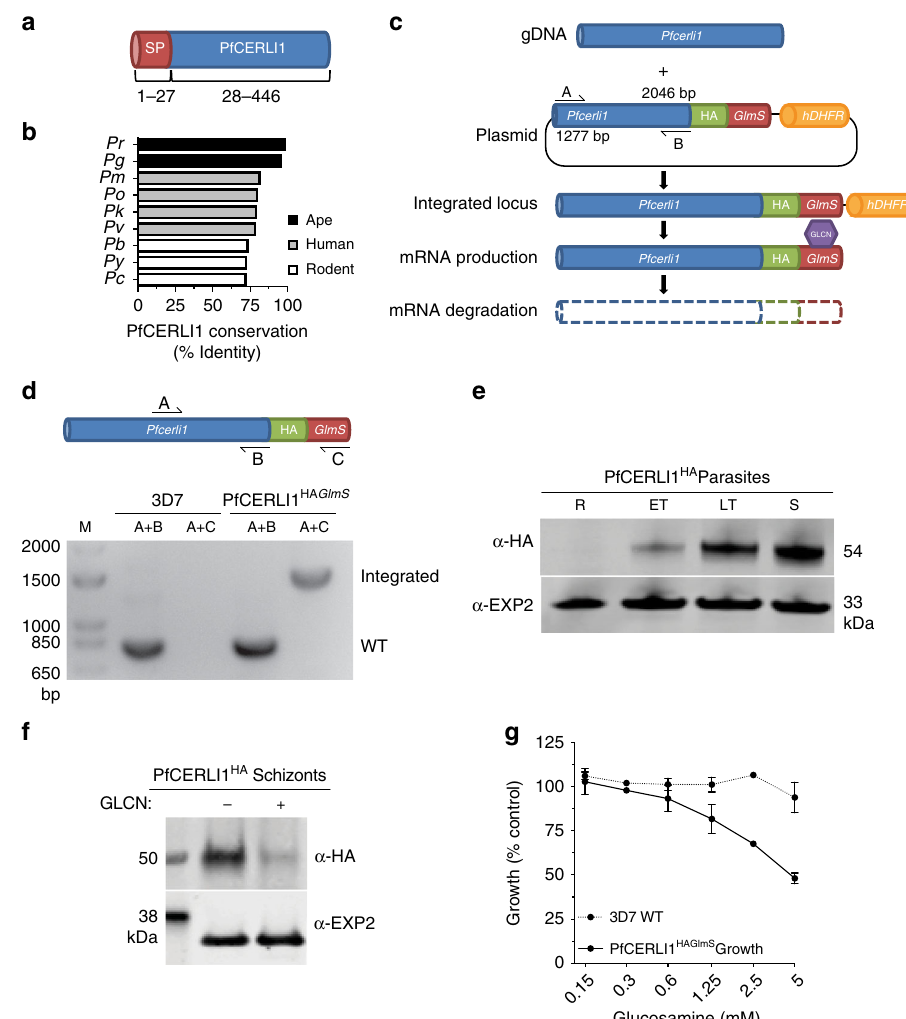
Fig. 1 Phylogeny of PfCERLI1 (Pf3D7_0210600) and development of genetic tools to investigate function. a PfCERLI1 is 446 amino acids in length